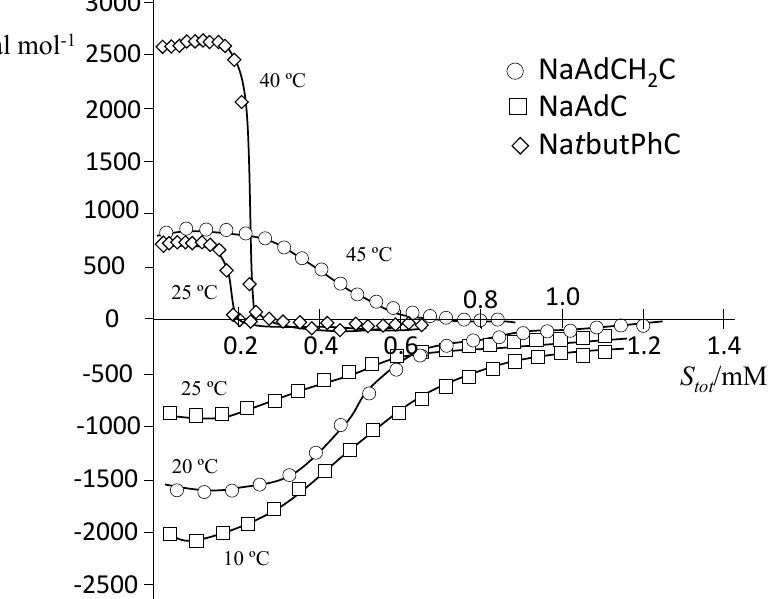
Figure 4. Representative ITC experiments in carbonate/bicarbonate buffer with a total concentration of 50.60 mM for NaAdC (squares, at 10 and 25 °C), NaAdCH 2 C (O, at 20 and 45 °C; and Na t butPhC (rhombuses, at 25 and 40 °C).